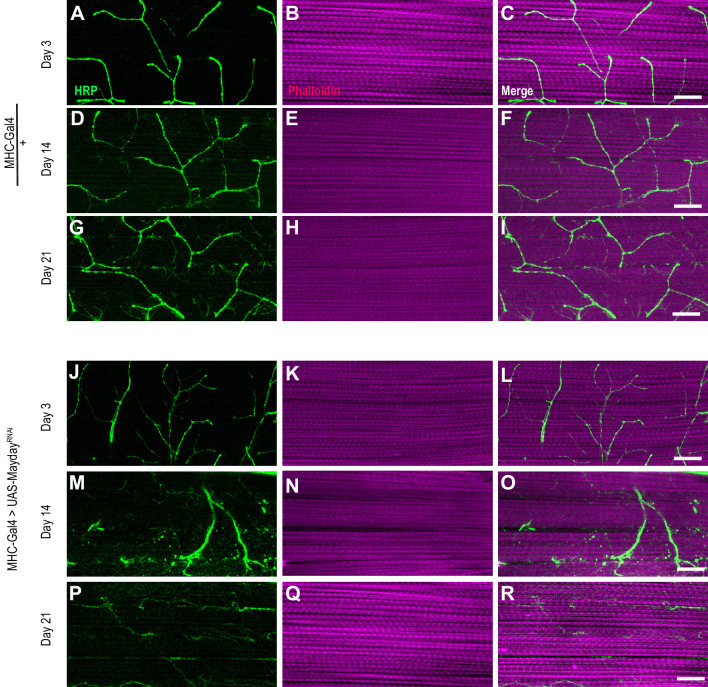
Morphology of Myd RNAi NMJs.Confocal Images of DLM NMJs labeled with FITC-conjugated HRP (green) and Phalloidin 647 (magenta) at ×63 magnification in both control flies (A-I) and those with muscle-specific knockdown of myd (J-R). Scale bar in R represents 20 µM for all panels.